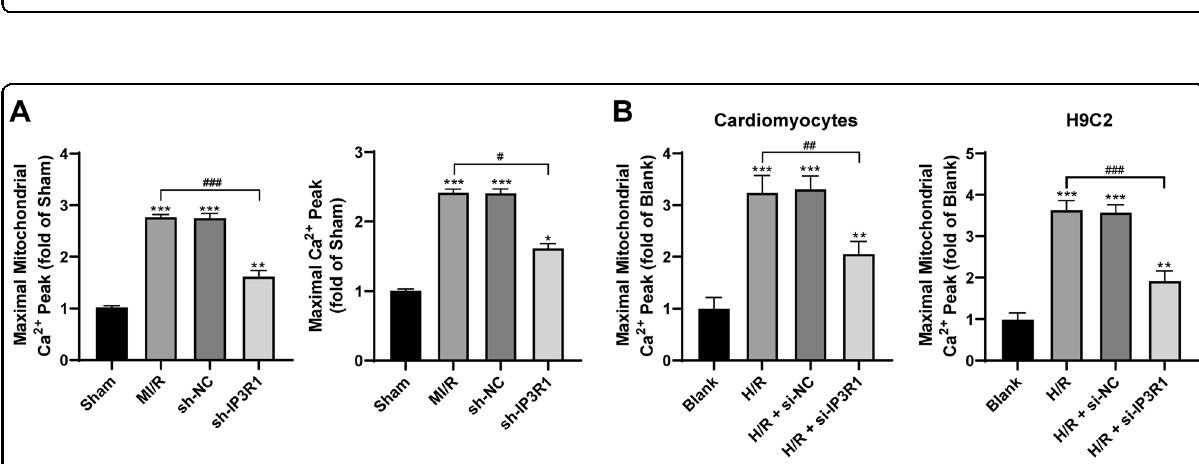
Fig. 2 Inhibition of IP3R1 attenuates H/R-induced pyroptosis and in fl ammation in cardiomyocytes. A RT-qPCR was used to detect the ef fi ciency of siRNA transfection; B CCK-8 was used to detect cell viability; C Western blot was used to detect the levels of pyroptosis-related proteins; D colorimetric method was used to detect the activity of Caspase-1; E ELISA was used to detect the levels of IL-1 β and IL-18. Cardiomyocytes are isolated and cultured from adult rat myocardium. Compared to the blank group, * p < 0.05, ** p < 0.01, *** p < 0.001; for pairwise comparison, # p < 0.05, ## p < 0.01, ### p < 0.001. Data in panels A / D were analyzed using one-way ANOVA and data in panels B / C / E were analyzed using two-way ANOVA. Tukey ’ s multiple comparison test was applied for the post hoc test after ANOVA.